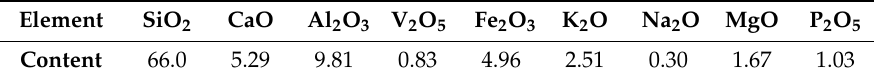
Figure 2. Quantitative evaluation of minerals by scanning electron microscopy (QEMSCAN) analysis result for the stone coal roasted residue.